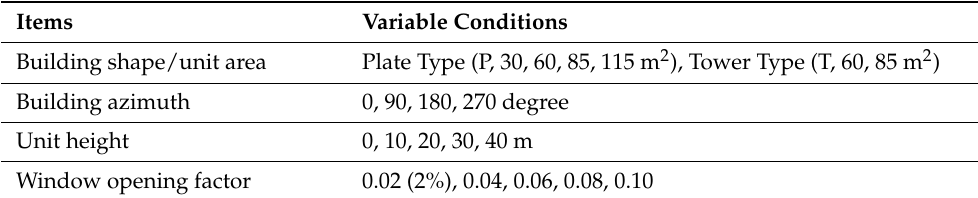
Table 5. Items and variable conditions for hybrid ventilation simulation.